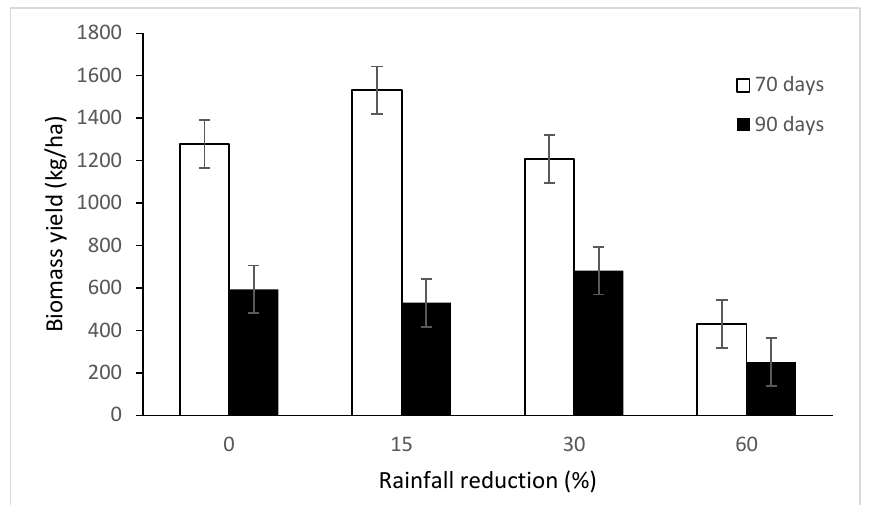
Figure 4. Mean interaction effect of rainfall reduction and resting period on grass biomass yield in autumn 2016/17 (bars indicate standard error values).